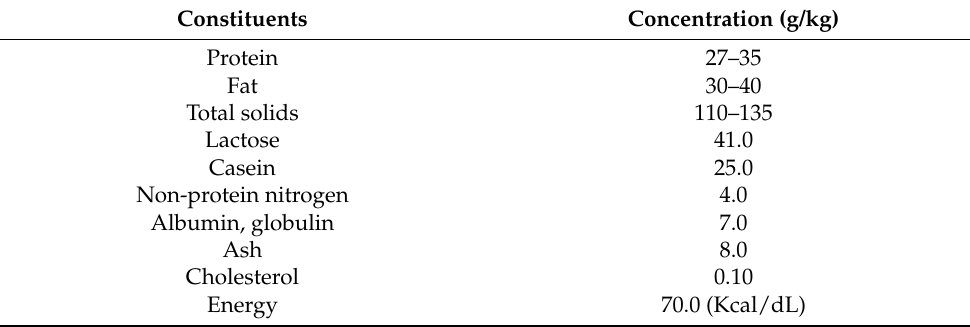
Table 1. Average macronutrient composition of GM. Source: [1].